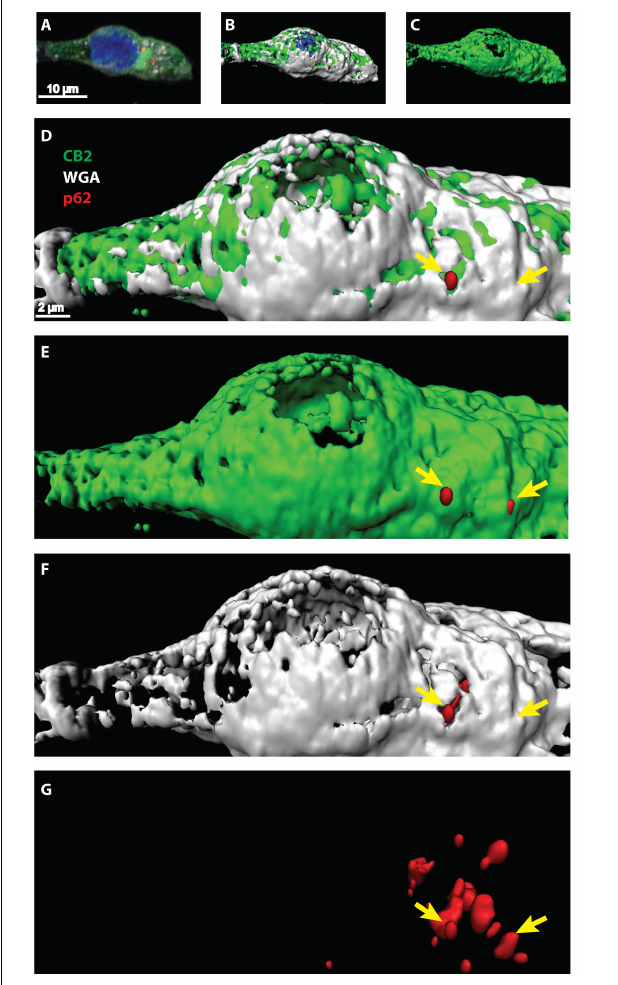
FIGURE 4 | (A–G) Confocal light microscopy of HEK293 cells transiently expressing CB2 receptors. (A) Immunohistochemical staining of CB2 (green), p62 (red), and DAPI (blue). The membrane was stained by Texas-red conjugated wheat-germ-agglutinin (white) and DAPI revealed the localization of the nucleus. (B–G) 3D reconstruction modeling of confocal images using a segmentation algorithm to distinguish single signal from different channels. (D–G) Higher zoom in of 3D reconstructed cell showing a strong overlap of CB2 positive areas with the membrane marker (white). P62 was found in vesicular like structures that intermingled with membranal CB2 positive areas (yellow arrows).